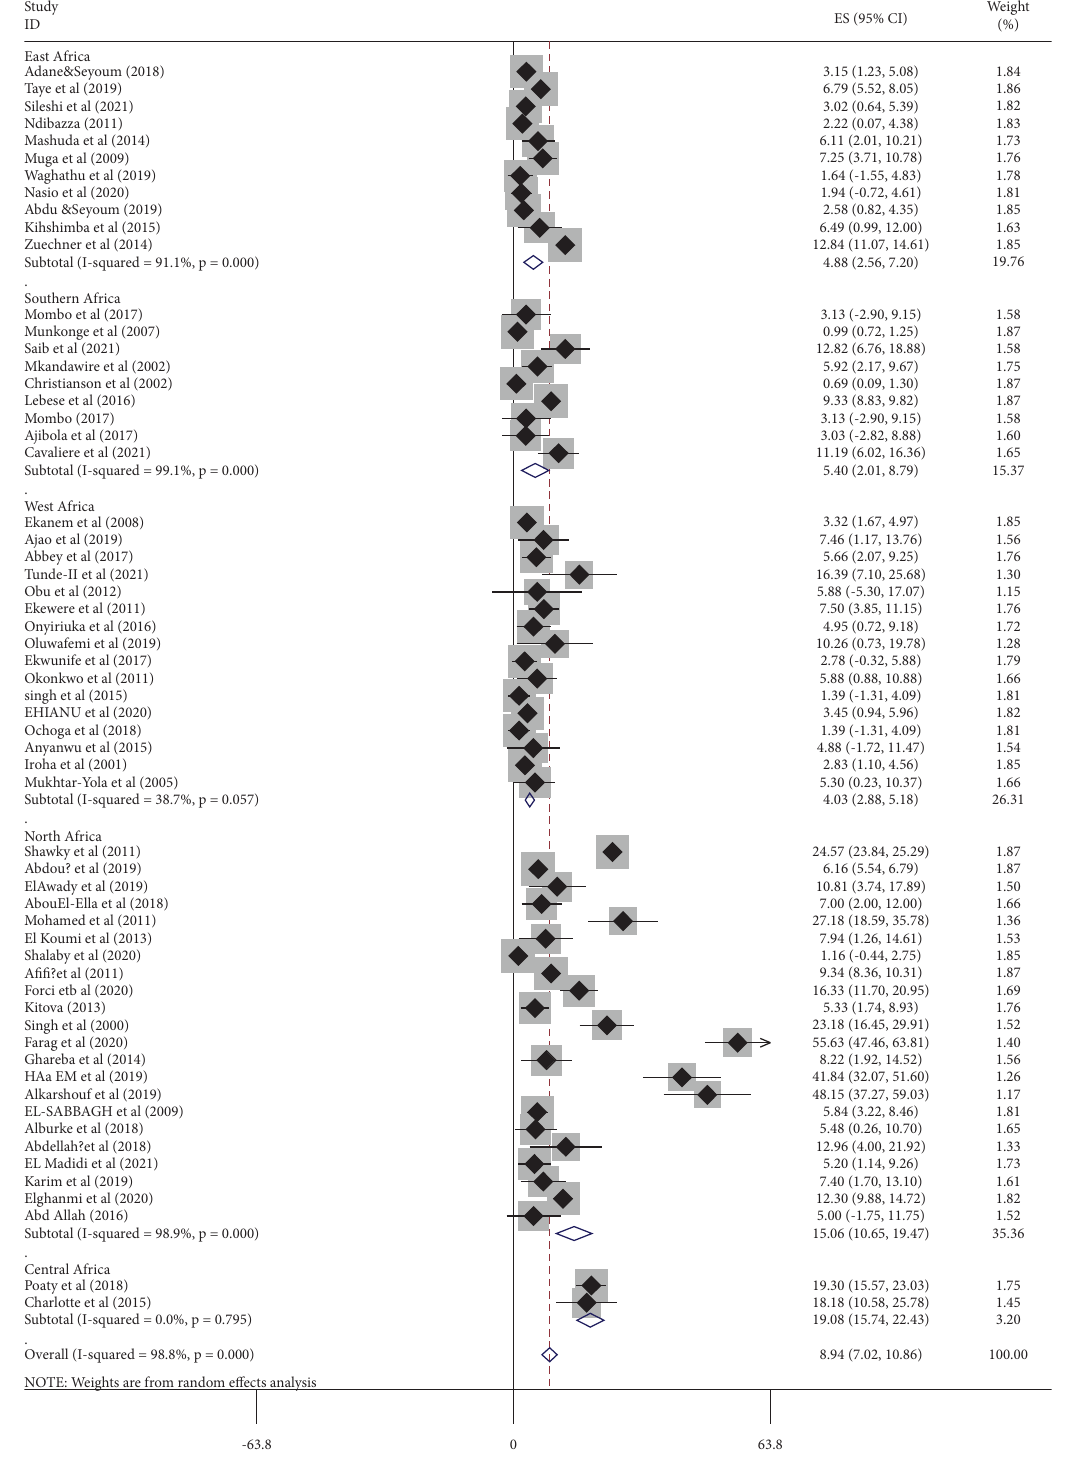
Figure 3: Forest plot on the pooled proportion of chromosomal disorders among births with congenital anomalies in Africa from January, 2000 to October,